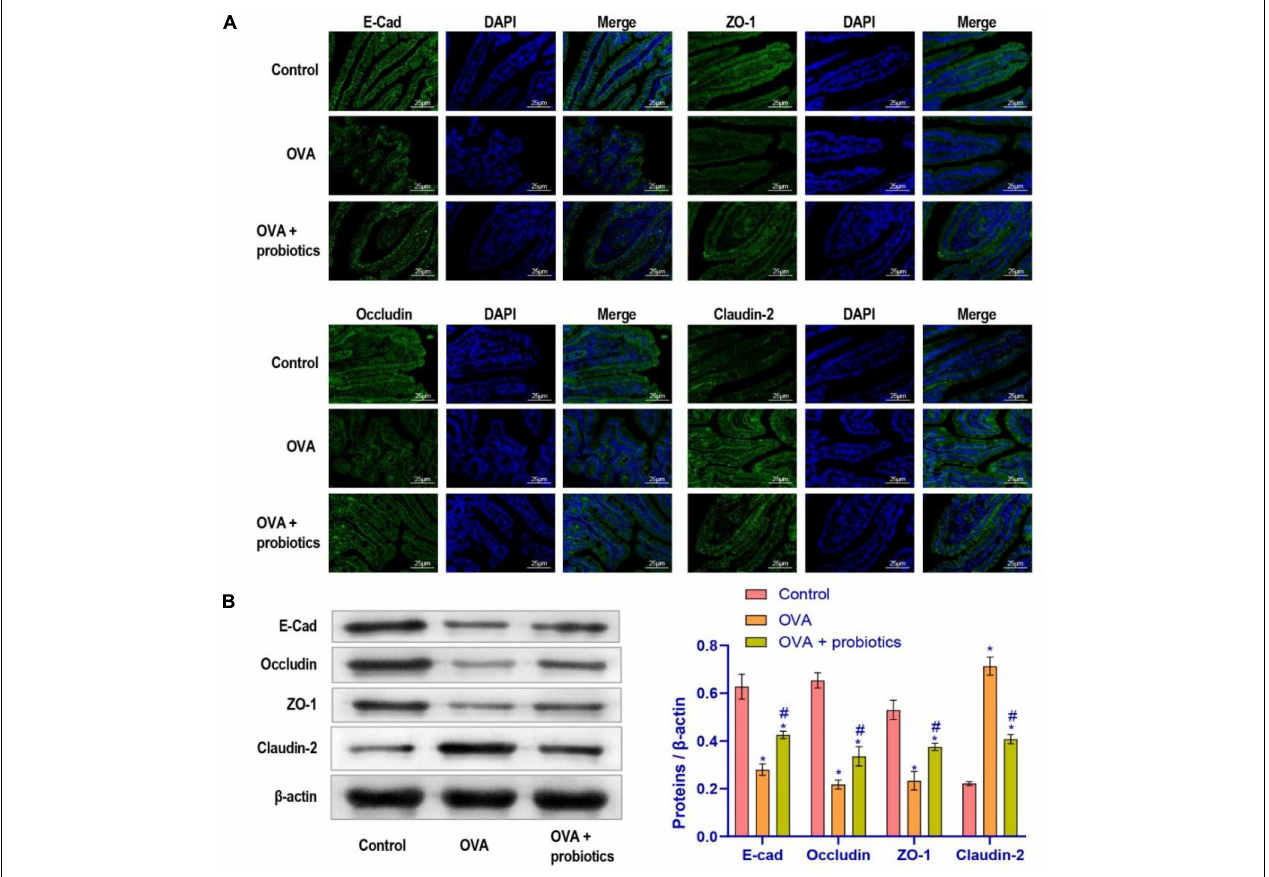
FIGURE 3 | The leakage of intestinal barrier was alleviated after supplementation of Lactobacillus fermentum CECT5716. (A) Immunofluorescence imaging of E-cad, ZO-1, Occludin, and Claudin-2 ( × 400, scale bar = 25 µ m). (B) Western blot was used to measure the expression of proteins. Protein expression levels of E-cad, ZO-1, Occludin, and Claudin-2 in each group. *Compared with the control group, P < 0.05. # Compared with the OVA group, P < 0.05. One-way ANOVA was used among multiple groups. n = 5 for each